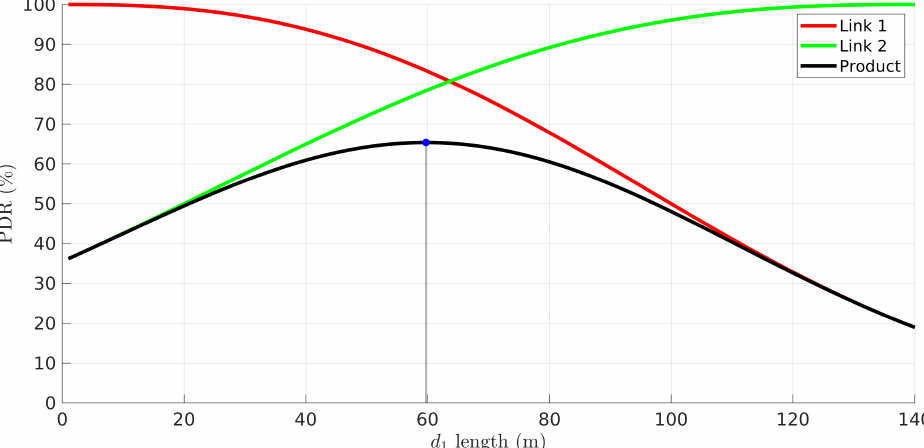
Figure 3. PDR of link 1 (red), link 2 (green), and their product, i.e., network (black), as a function of the length of the first link d 1 and L =